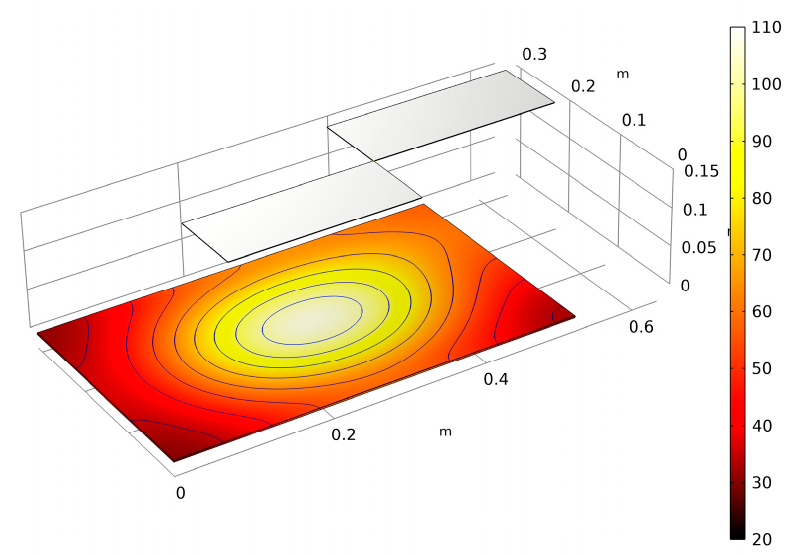
Figure 15. Temperature distribution on the sheet after 120 s (COMSOL Multiphysics V 5.6 software).